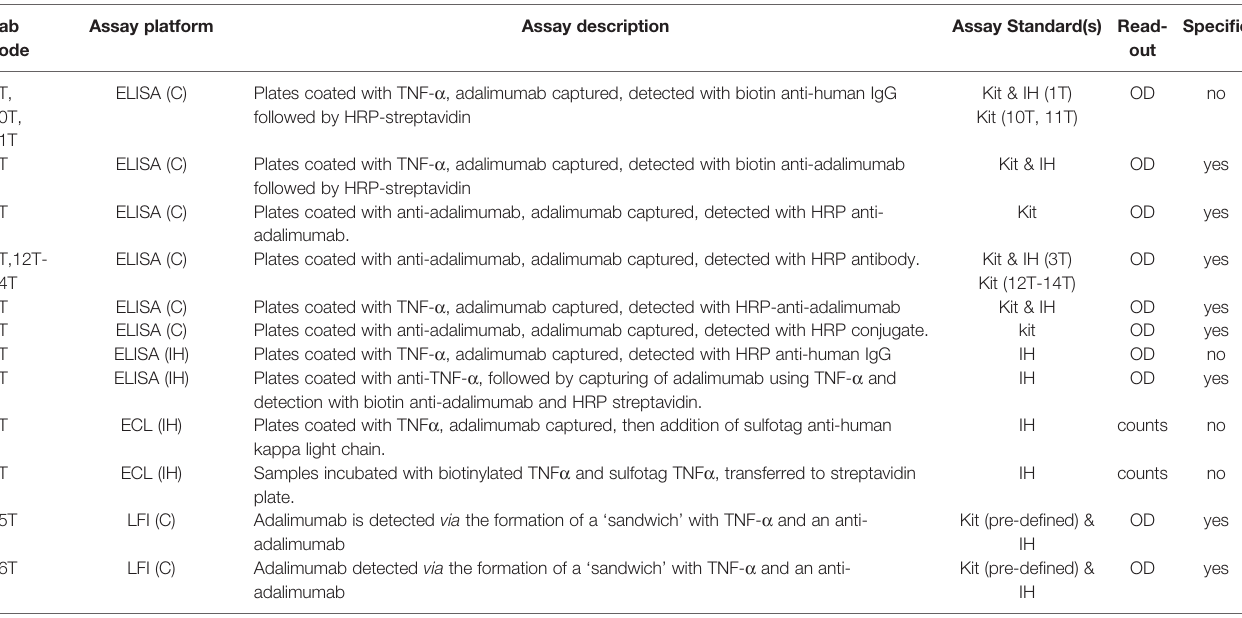
TABLE 8 | Brief details of assays contributed for assessing adalimumab levels. Lab Assay code